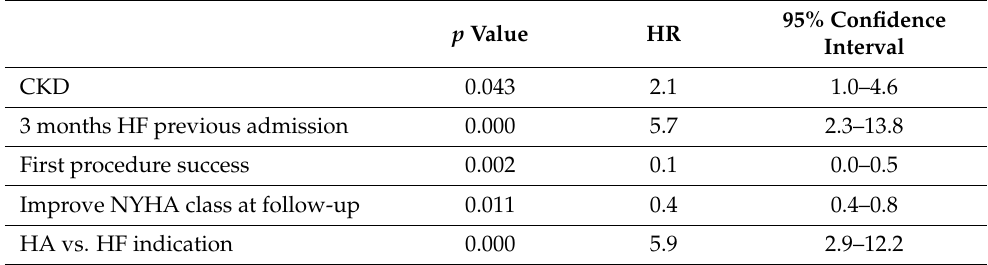
Table 5. Predictors of major adverse cardiovascular events (MACE) during long-term follow-up.